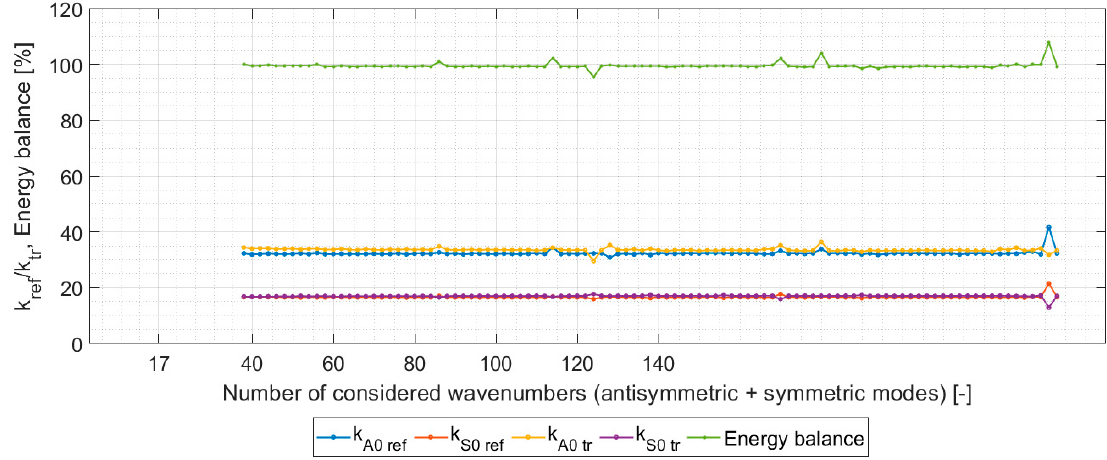
Figure 10. Numerical convergence of energy scattering coefficients in waveguide 1 (99% of reflected energy in sub-wave- guide 3).